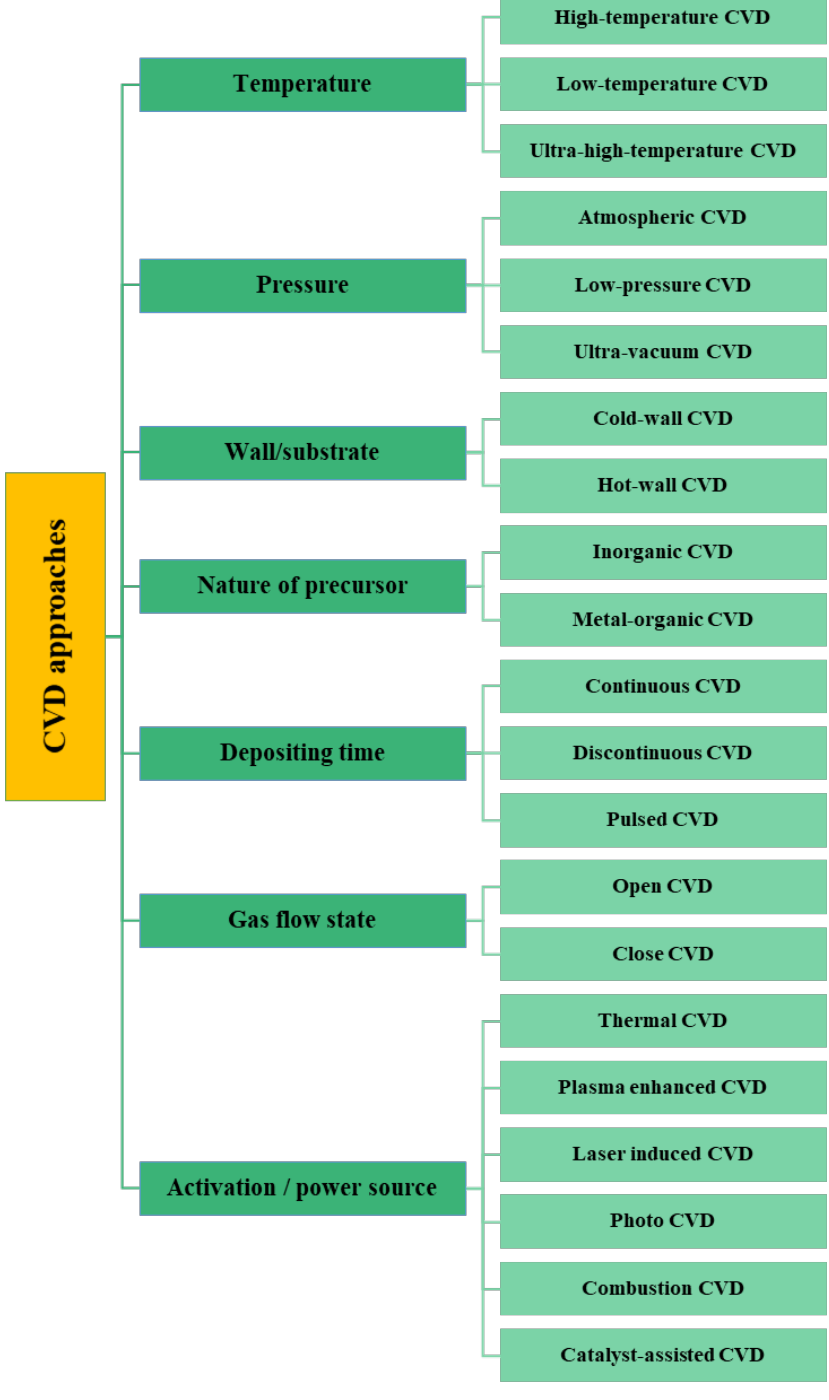
Figure 4. Summary of CVD methodologies.